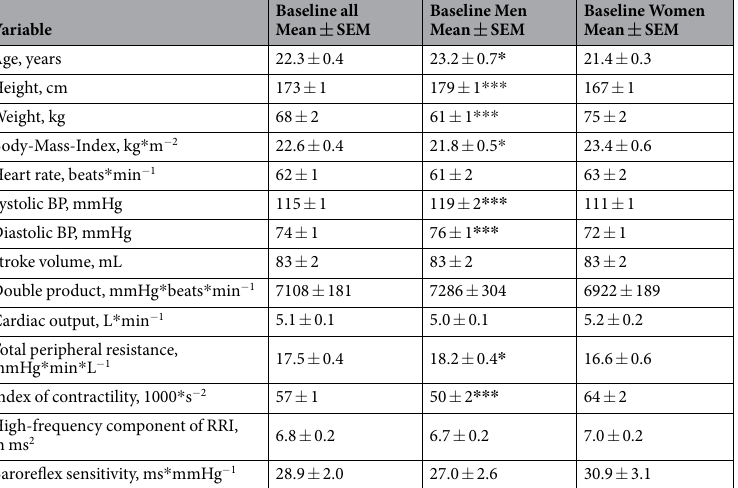
Table 1. Baseline anthropometric- and cardiovascular parameters for 45 (22 women) young and healthy subjects. All: Men and women combined; BP: blood pressure; RRI: RR-interval; ln: natural logarithm; statistical analysis was performed using an unpaired student’s t -Test where baseline values were compared between men and women. * P < 0.05 and *** P < 0.005 statistical significant differences between men and